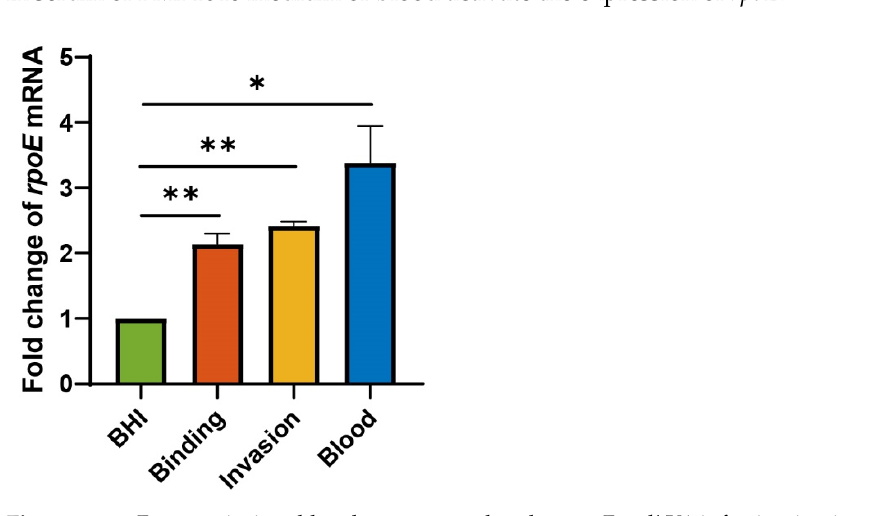
Figure 5. rpoE transcriptional levels are upregulated upon E. coli K1 infection in vitro and in vivo. * p < 0.05; ** p < 0.01 by Student’s t -test. Data are presented as the mean ± standard deviation; n = 3.